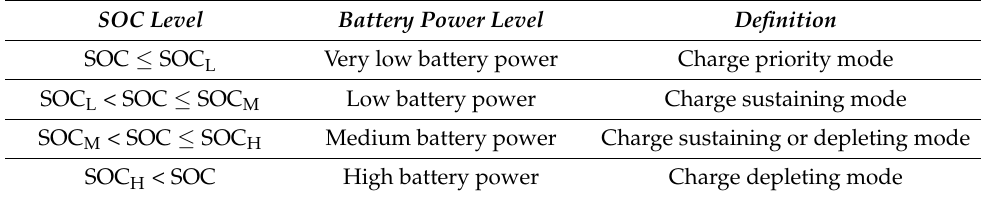
Figure 5. ( a ) Battery OCV–SOC curve; ( b ) internal resistance curve. Table 3. Battery working